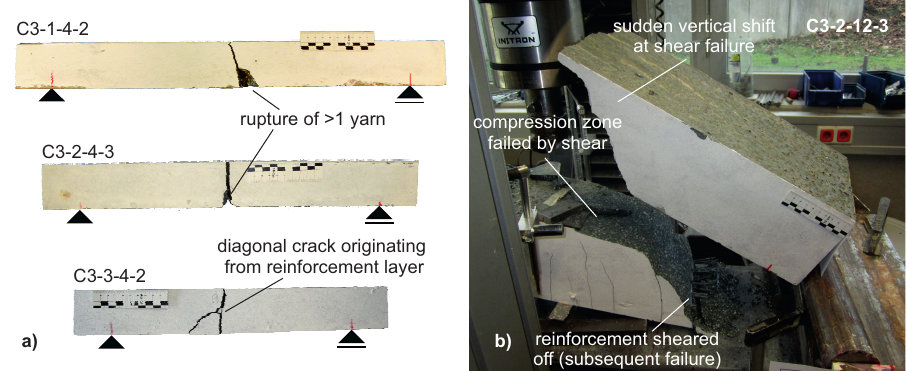
Figure 3. Failure mechanisms observed in experimental study ( a ) bending failure; ( b ) shear- compression failure.